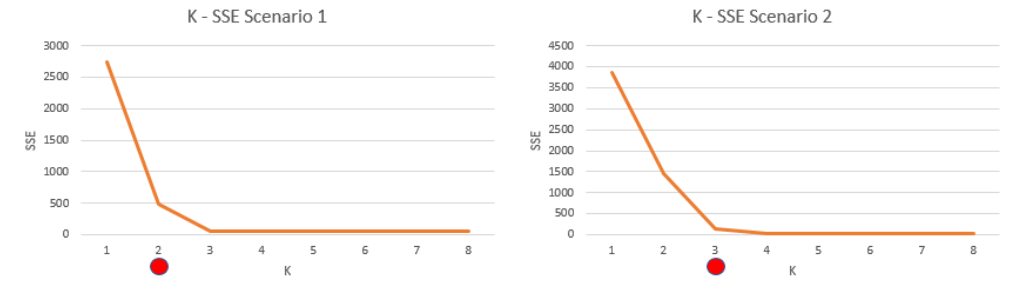
Figure 9. k to SSE graph